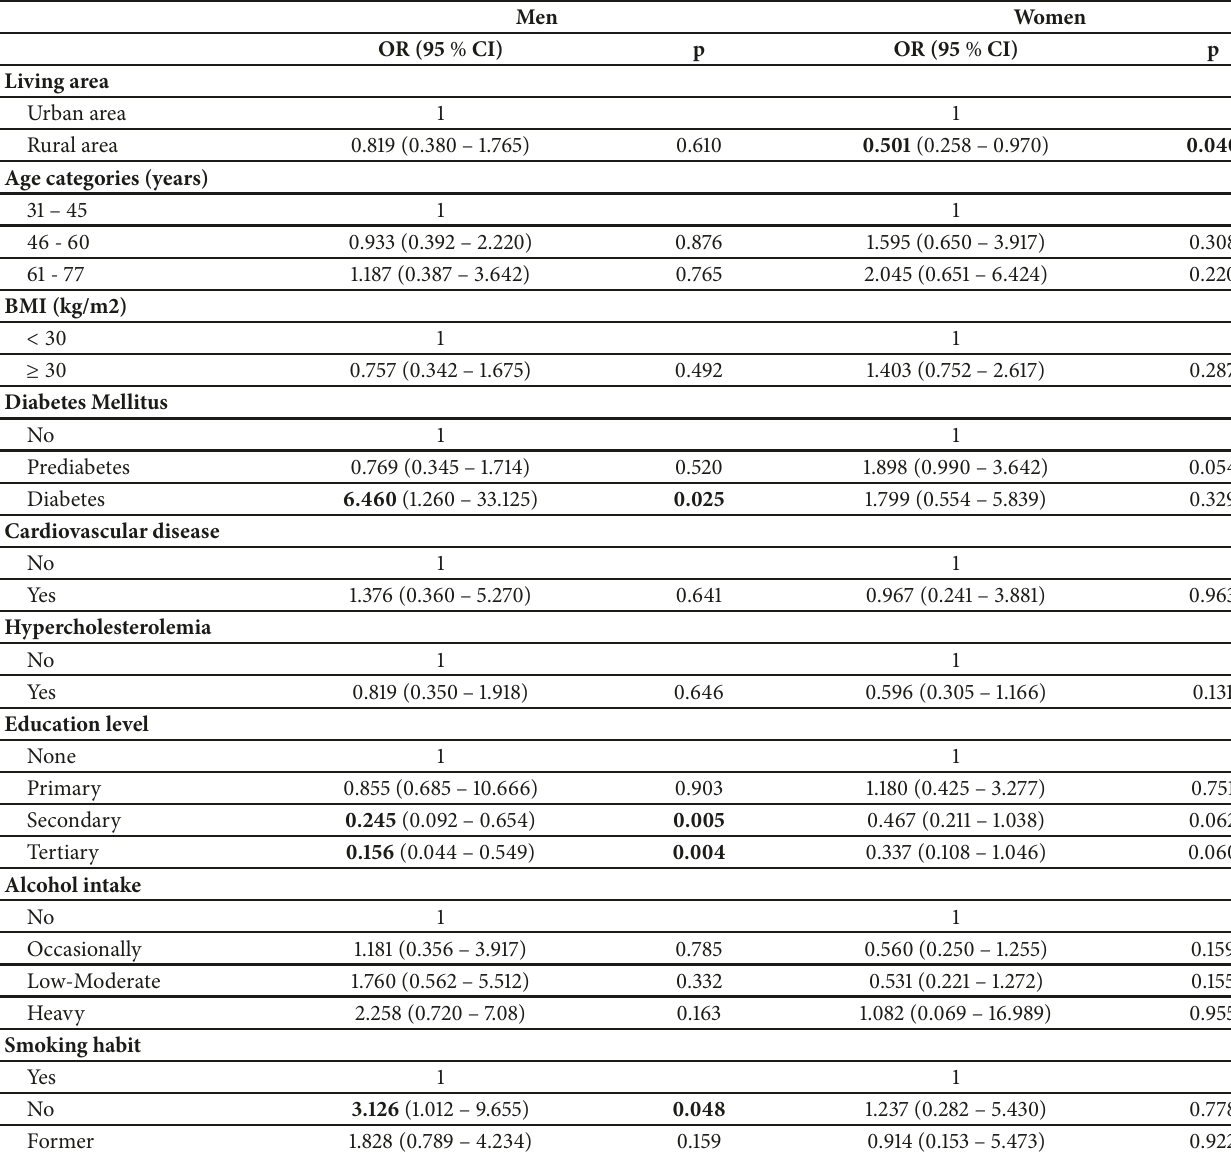
Table 4: Multiple logistic regression analysis of hypertensive treated subjects of being blood pressure uncontrolled after adjusting for age, body mass index, diabetes, cardiovascular disease, hypercholesterolemia, education level, alcohol, and smoking